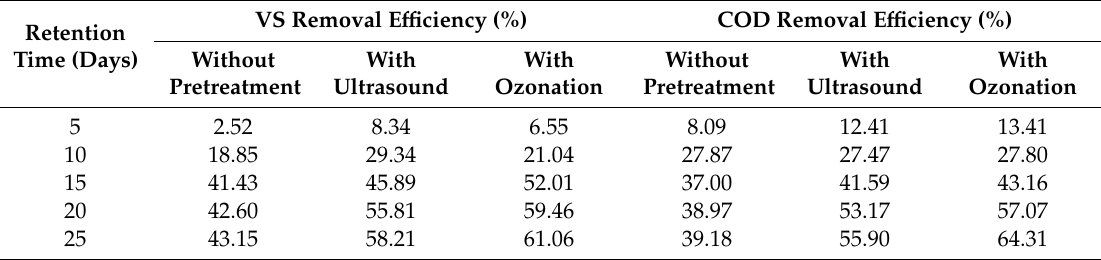
Table 2. Chemical oxygen demand (COD) and volatile solids (VS) removal e ffi ciencies of